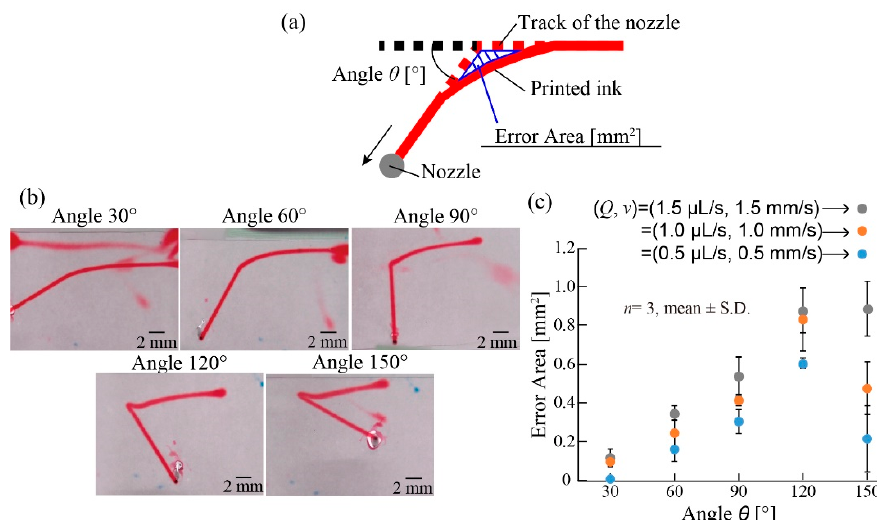
Figure 5. Evaluation of printed ink pattern. ( a ) The error area is defined as the dragged area of the patterned ink at the corner. ( b ) Images of the printed corners with different angles θ . The patterned ink ( v = 1.0 mm/s, Q = 1.0 µL/s) was distorted depending on the angle of the corner. ( c ) Relationship between the error area and θ with different Q and v values . The error area increased as the angle increased, reaching the maximum when the angle was 120° for all three nozzle speeds. For all angles, the slower the nozzle speed, the lower the error area.